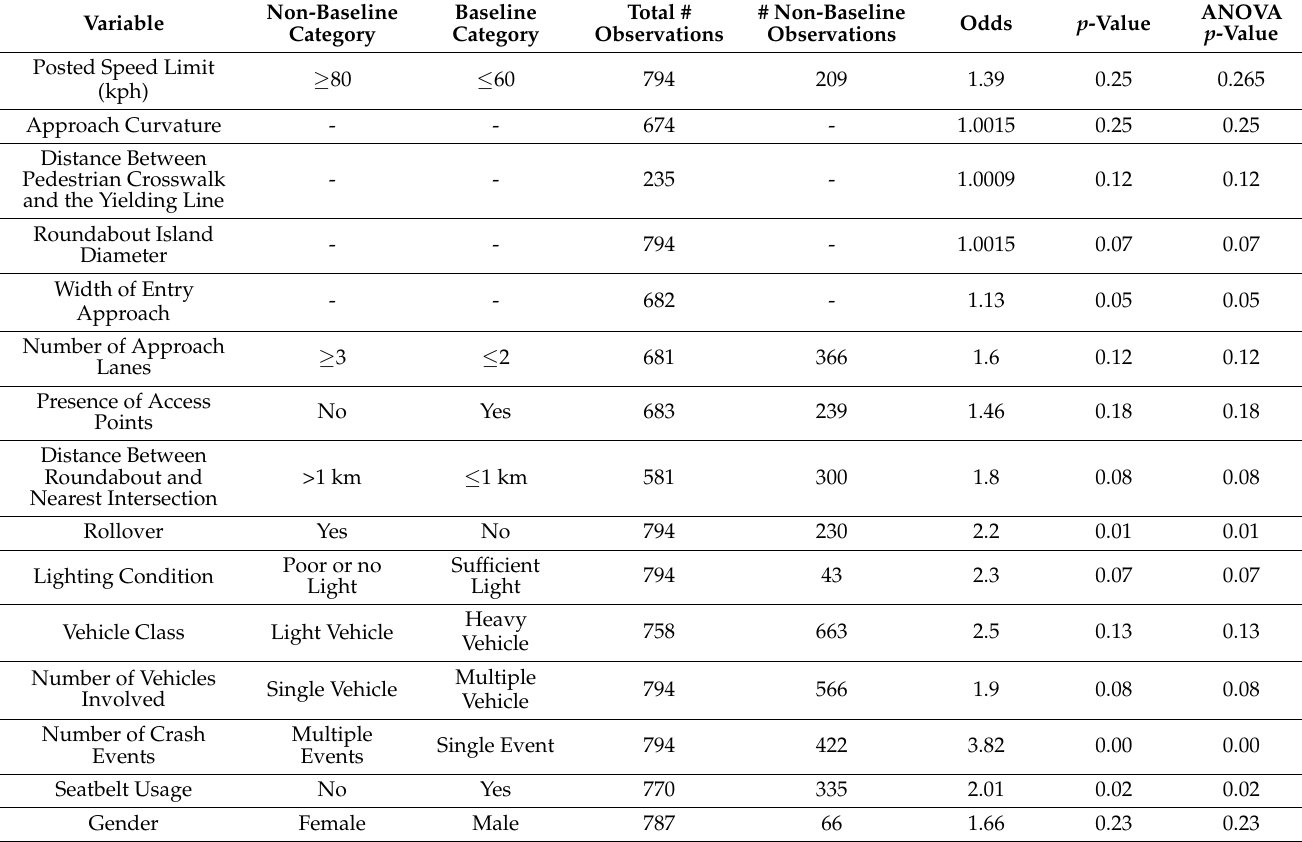
Table 6. Univariate Analysis: Roundabouts.